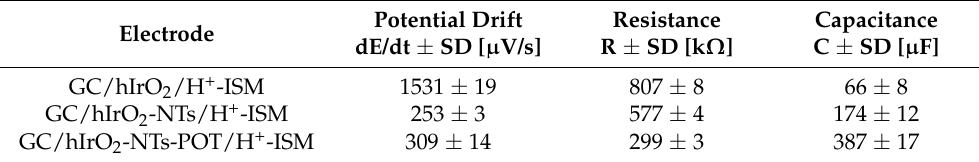
Table 2. Electrical parameters calculated for the linear part of the recorded chronopotentiograms with standard deviation values (n = 6 steps).